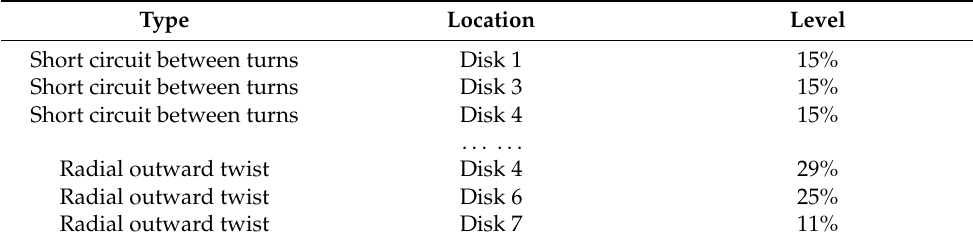
Table 2. Validation sets.